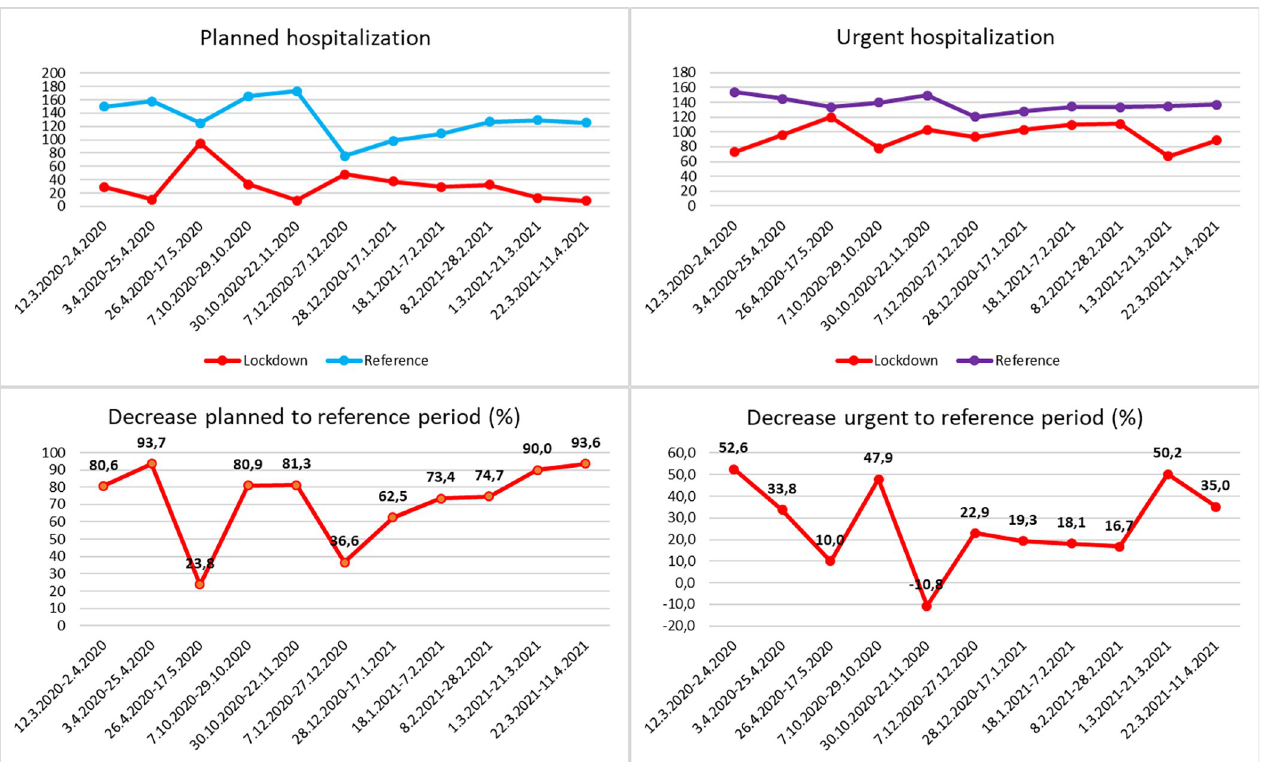
Fig 2. Overview of inpatients. Correlation of the number (y-axis) of elective (left) and acute inpatients (right) in the lockdown period and the reference period (in the upper part). In the case of the reference period, the average of the previous 3 years before the pandemic is calculated. Percentage decrease of inpatients in individual periods (in the bottom part). Negative values indicate an increase of